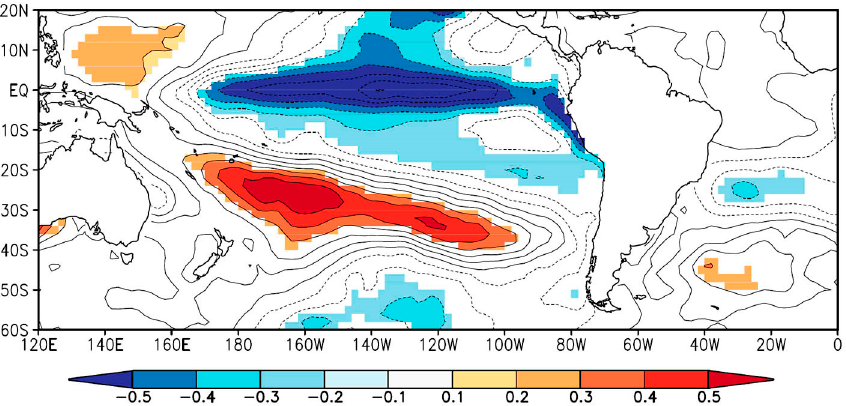
Figure 10. Composite of SST (Extended Reconstructed Sea Surface Temperature v3b, [46]) anomalies (1989–2014) during the months showing more than 70% of the stations with hydrological drought conditions. Color areas are significant at the 95% significance level.